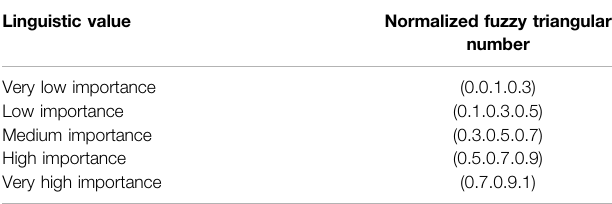
TABLE 8 | Expert linguistic values and corresponding normalized triangular fuzzy numbers. Linguistic value